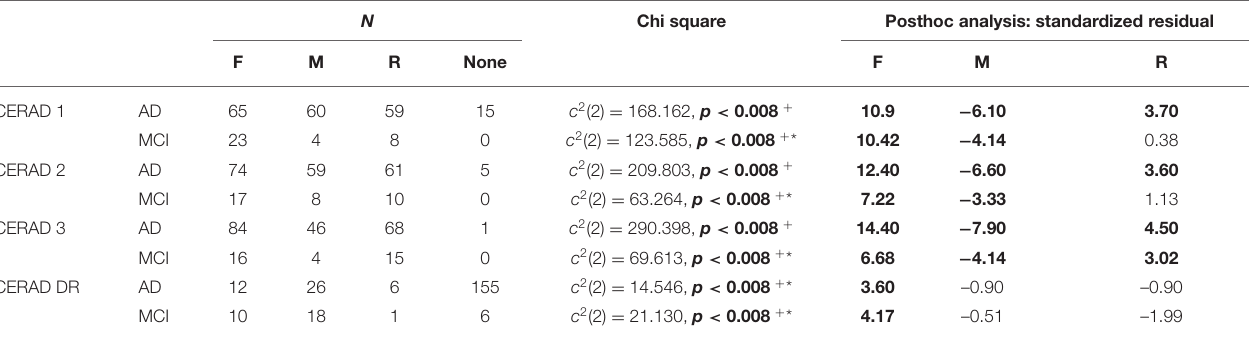
TABLE 2 | Primacy and recency effects, calculated using the first word recalled measure.